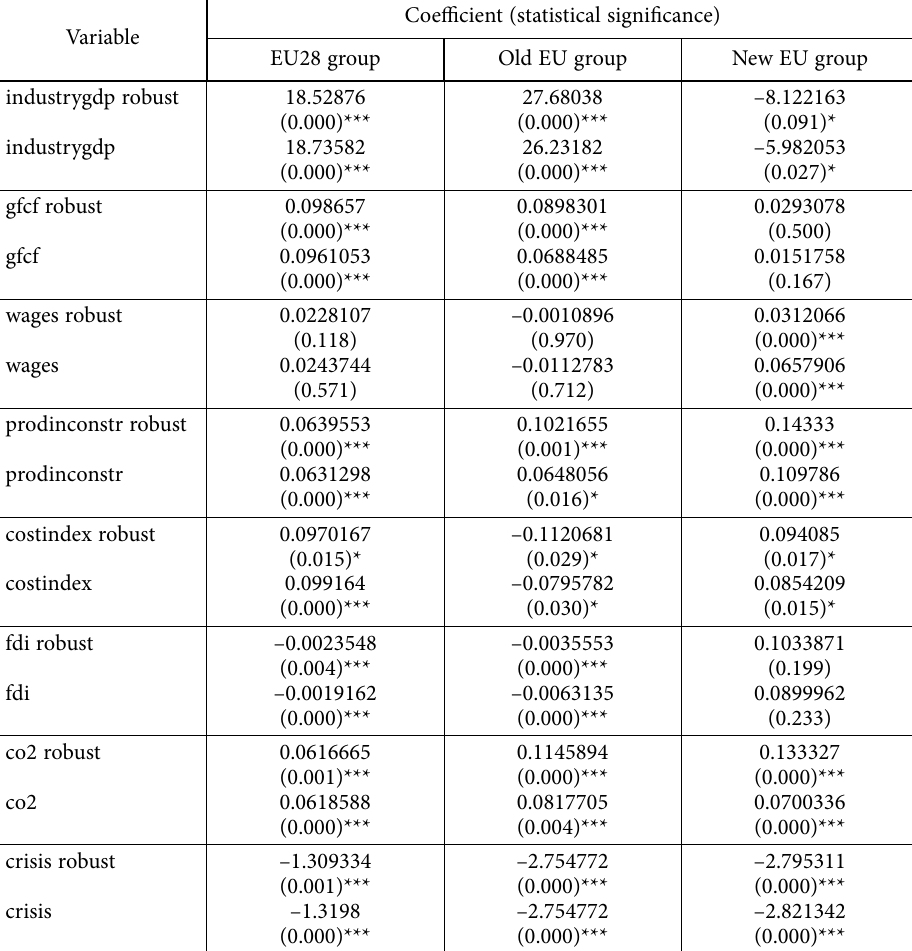
Table 6. Results of our economic growth model determinants in EU28, old EU and new EU group (source: Stata, Authors’